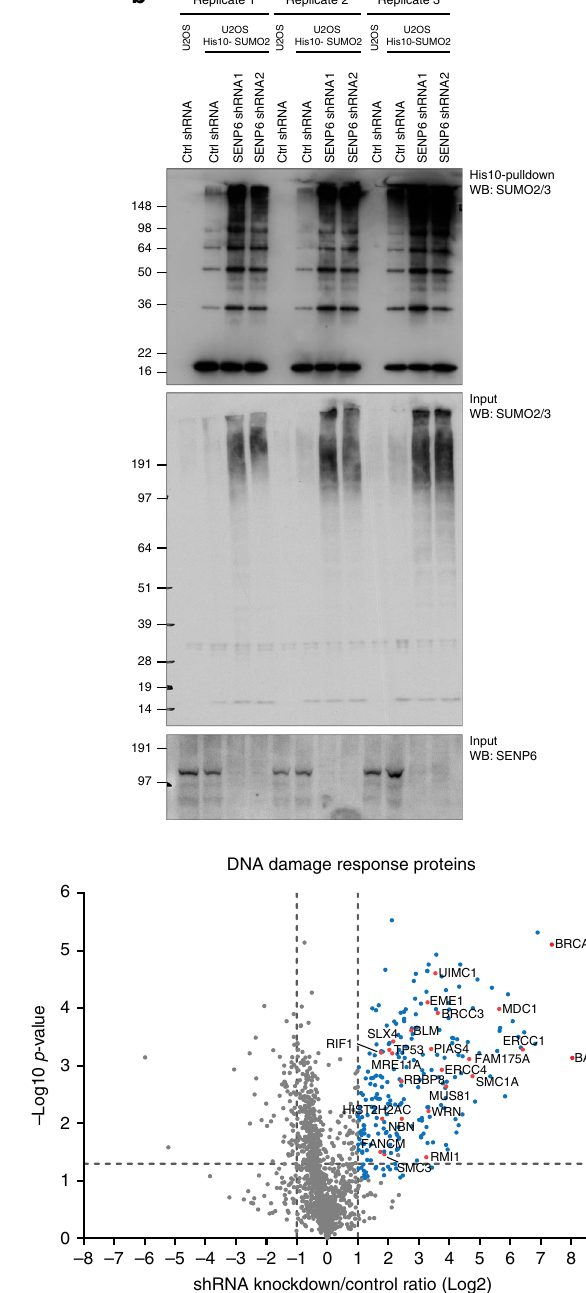
against SENP6 was used to con fi rm ef fi cient knockdown. c Volcano plot showing all identi fi ed proteins within the SENP6 knockdown samples compared with the nontargeted control shRNA. Dashed lines indicate a cutoff at twofold change (log2 = 1) and a p -value of 0.05 ( − log10 = 1.3), n = 3 independent experiments. SUMOylated proteins represented as blue circles were more abundant after SENP6 knockdown. The left panel shows identi fi ed centromere proteins and protein involved in centromere regulation represented by red circles, whereas the right panel shows DNA damage response proteins represented in red circles. Source data are provided as a Source Data fi